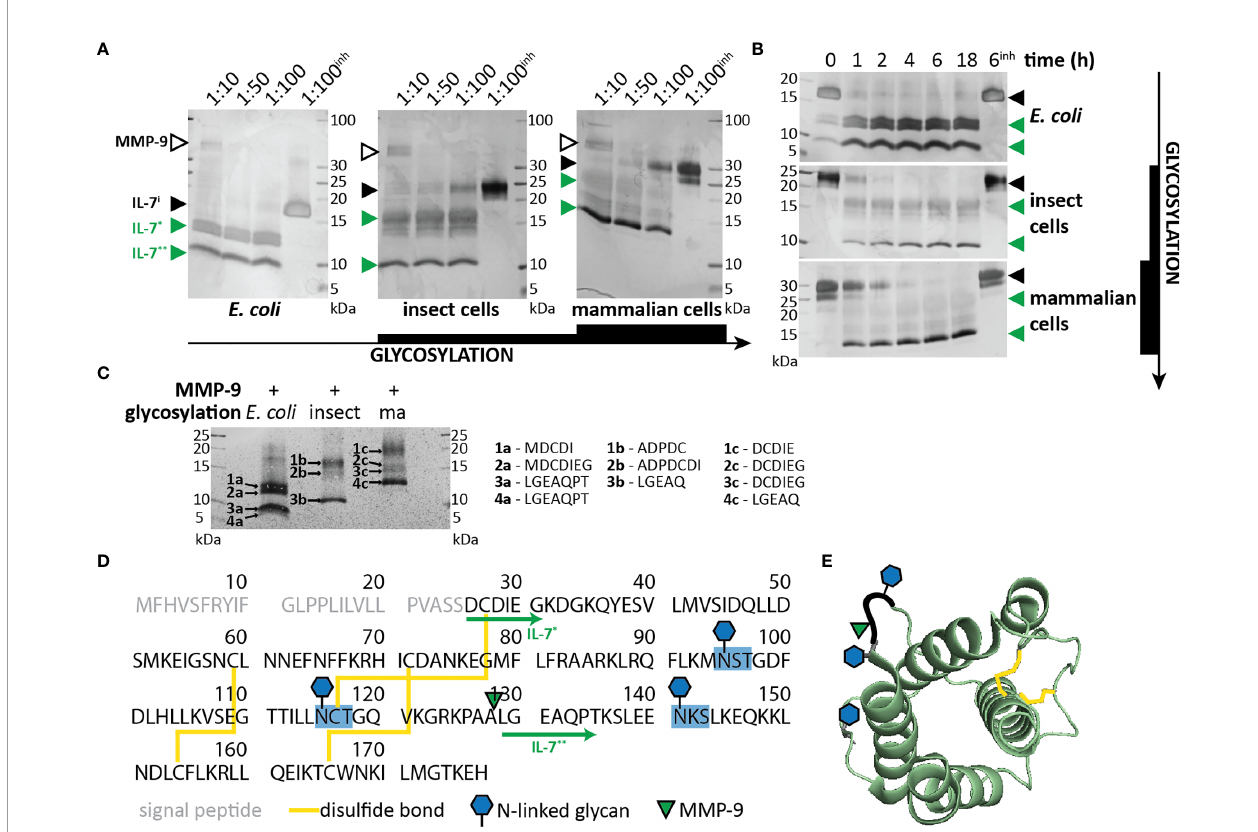
FIGURE 1 | Characterization of IL-7 cleavage by MMP-9. (A) Recombinant IL-7 produced in E. coli (left), insect cells (middle) or human HEK-293 cells (right) were incubated with different concentrations of active MMP-9 at the indicated molar ratios (MMP-9/IL-7), for a period of 2h. Fragments were separated by SDS-PAGE under reducing conditions followed by silver staining. MMP-9, intact IL-7 (IL-7 i ) and two cleavage products (IL-7* & IL-7**) are indicated with arrowheads, respectively, in black and green color. inh ; negative control in the presence of 500 µM of the MMP inhibitor SB-3CT (inh). (B) Recombinant IL-7 produced in E. coli (top, non-glycosylated), insect cells (middle, partially glycosylated) or human HEK-293 cells (bottom, fully glycosylated) were incubated with active MMP-9 at a molar ratio of 1:100 (MMP-9/IL-7) and samples were taken at the indicated time-points. Fragments were resolved by SDS-PAGE under reducing conditions. Intact IL-7 (IL- 7 i ) and two cleavage products (IL-7* & IL-7**) are indicated with arrowheads, respectively, in black and green color. inh ; negative control in the presence of 500 µM of the MMP inhibitor SB-3CT. (C) , Edman sequencing data. Identi fi cation of the neo-N-termini generated upon digestion of IL-7 with MMP-9 (1:100, MMP-9:IL-7 for 6h). Identi fi cation of the LGEAQ N-terminus from fragment IL-7**, indicates an MMP-9 cleavage site between the amino acid residues A 128 and L 129 . Variations in N- terminal amino acids of fragments IL-7* are due to the different IL-7 expression systems ( Supplementary Table 1 ). (D) Amino acid sequence of human IL-7 with indication of glycosylation sites (blue), disul fi de bridges (yellow), MMP-9 cleavage site (green triangle) and IL-7 fragments (green arrows). (E) 3D model of IL-7 [PDB structure 3DI3 (29)] with indication of the location of the MMP-9 cleavage site (green triangle), glycosylation sites (blue hexagons) and disul fi de bridges